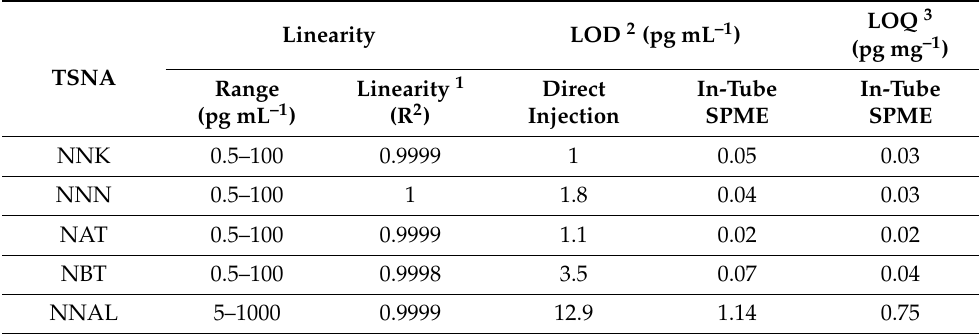
Table 1. Linearity and sensitivity of the in-tube SPME LC–MS/MS method for TSNAs.